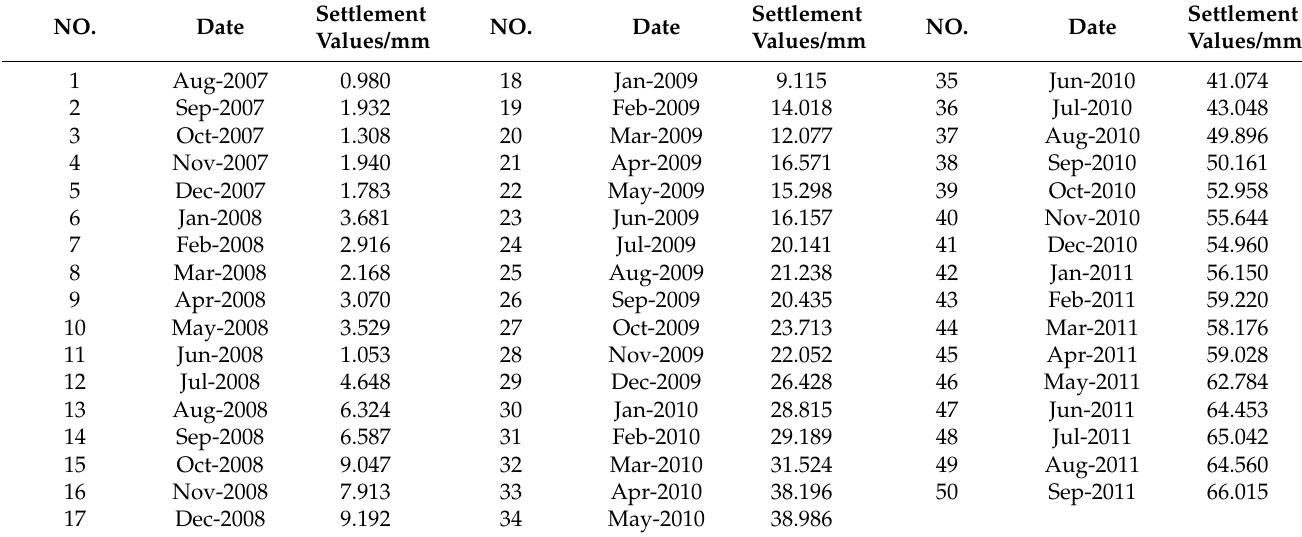
Table 1. The accumulated settlement value of monitoring point ZLD-01 from Aug-2007 to Sep-2011.